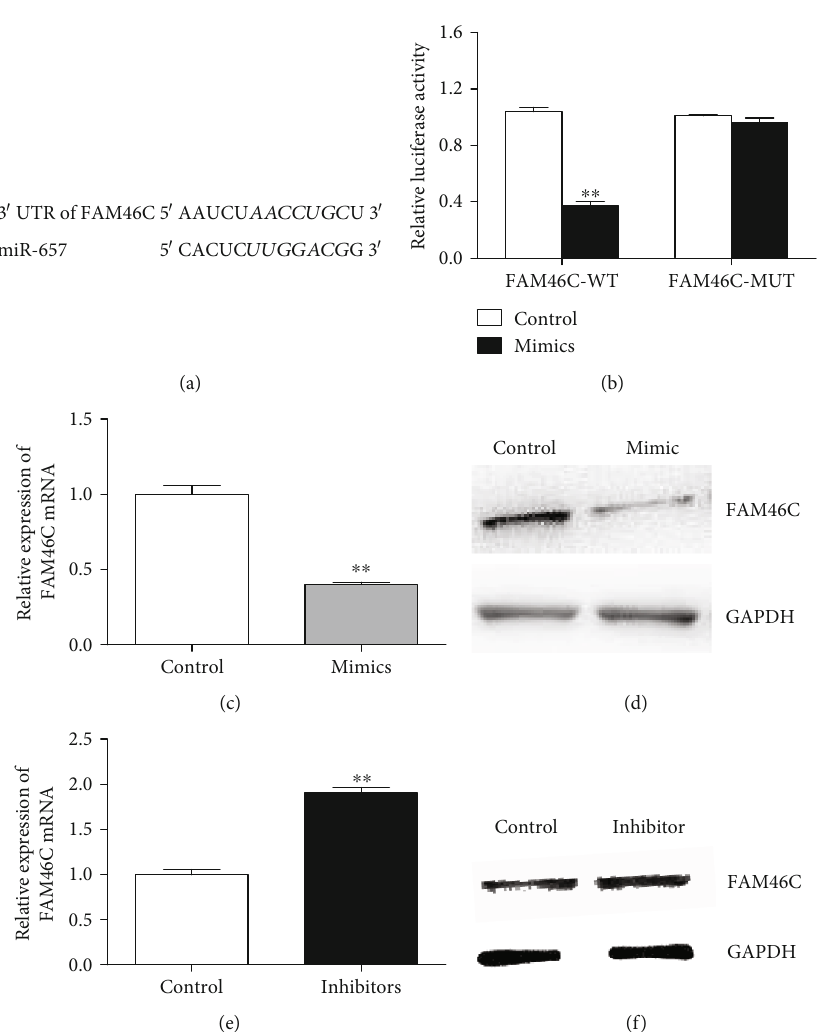
Figure 4: miR-657 can targetly regulate FAM46C. (a) miR-657 specially recognizes the 3 ′ UTR of FAM46C. (b) Luciferase reporter assay shows FAM46C is the direct target of miR-657 ( ∗∗ P < 0 : 01 ; representative data of three repeated tests). (c) Decreased mRNA expression of FAM46C in miR-657 mimics treated THP-1 macrophages ( ∗∗ P < 0 : 01 ; representative data of three repeated determinations). (d) Decreased protein expression of FAM46C in miR-657 mimics treated THP-1 macrophages determined by western blot (representative picture of three repeated tests). (e) Elevated mRNA expression of FAM46C in miR-657 inhibitors treated THP-1 cells ( ∗∗ P < 0 : 01 ; n = 3 ). (f) Increased protein expression of FAM46C in miR-657 inhibitors treated macrophages (representative picture of three independent